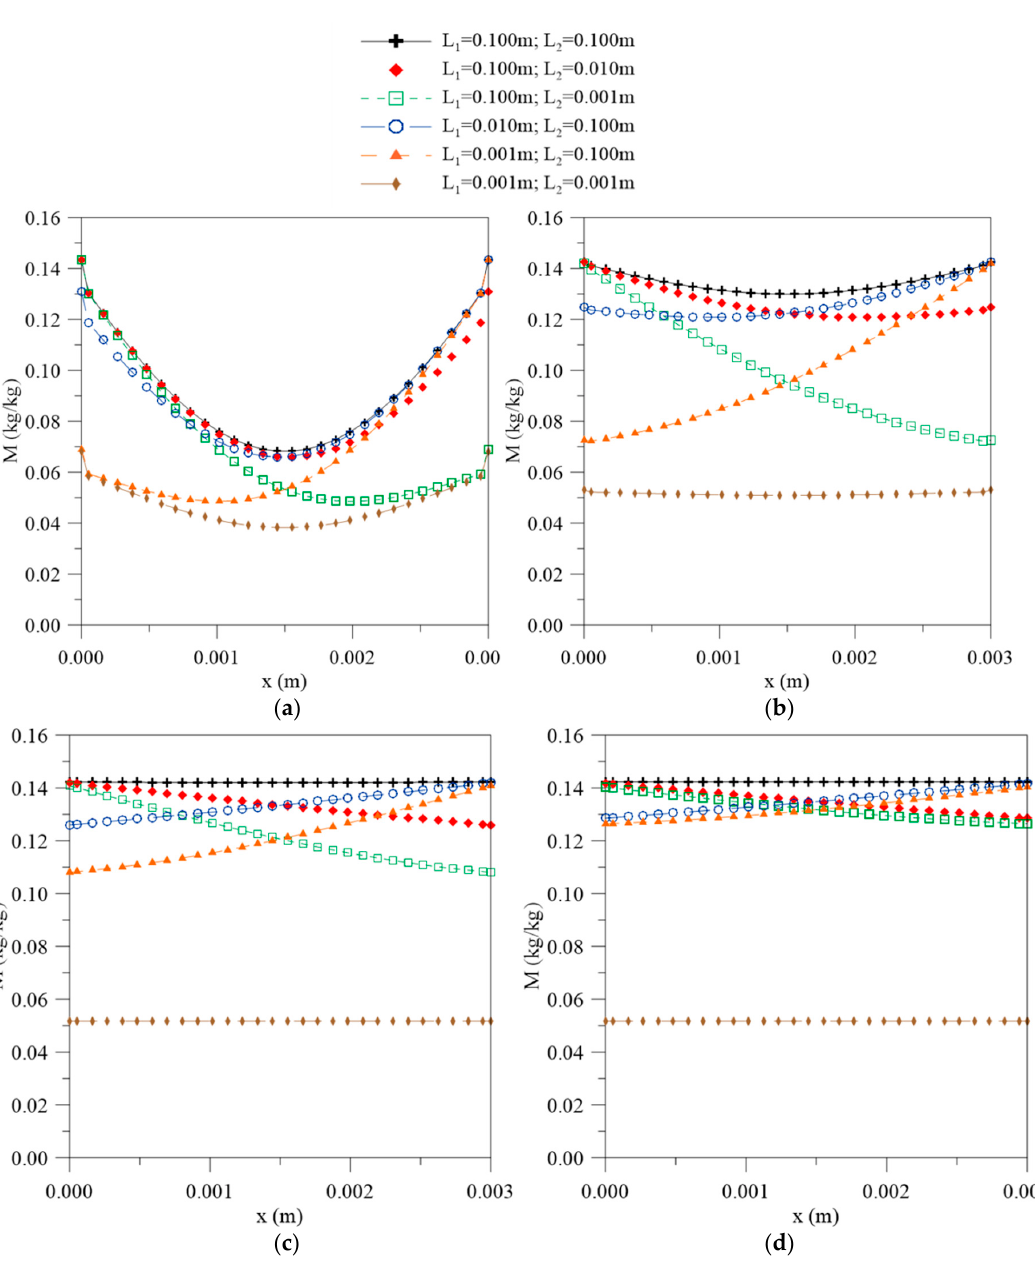
Figure 4. Local moisture content as function of the position inside the material at different process times: ( a ) 56, ( b ) 195, ( c ) 500, and ( d ) 1944 h.